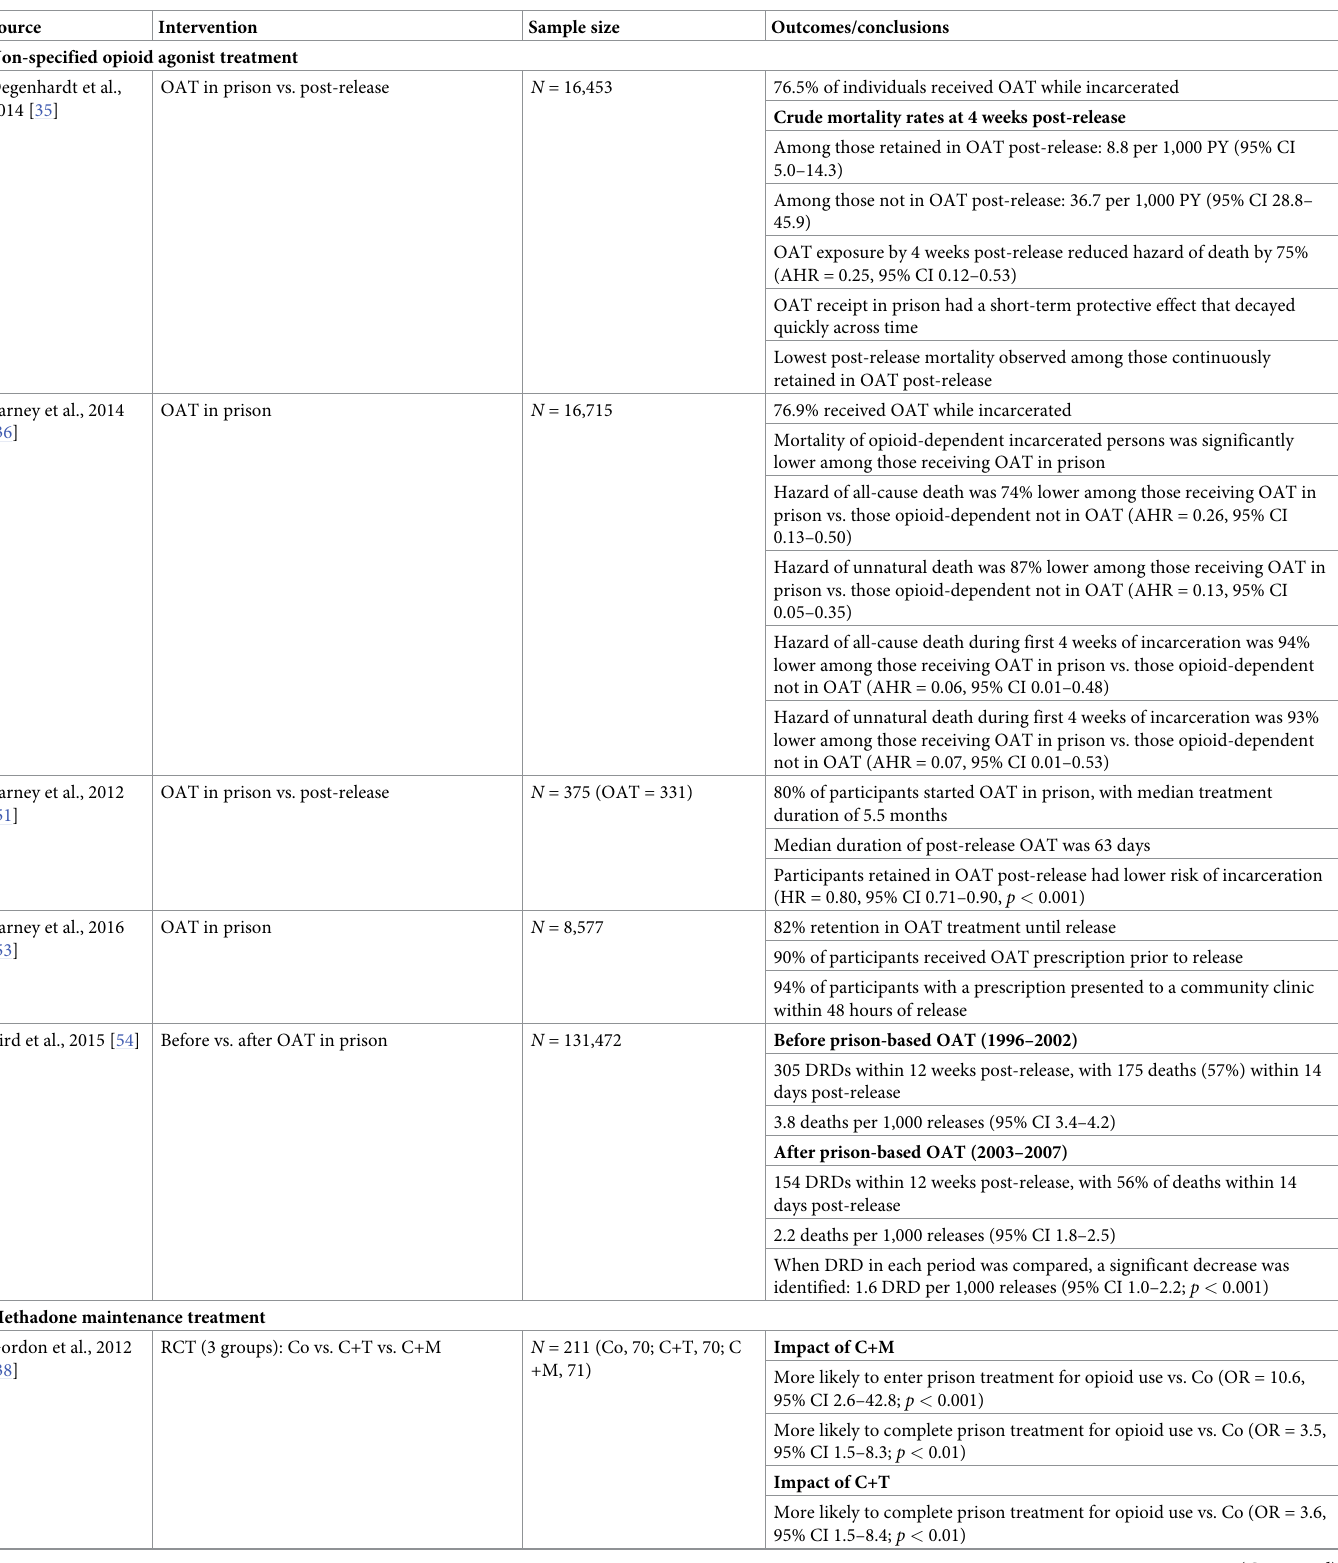
Table 2. Description of interventions and outcomes of opioid use intervention studies during a continuum of treatment (before, during, and after incarceration), 2008–2019.